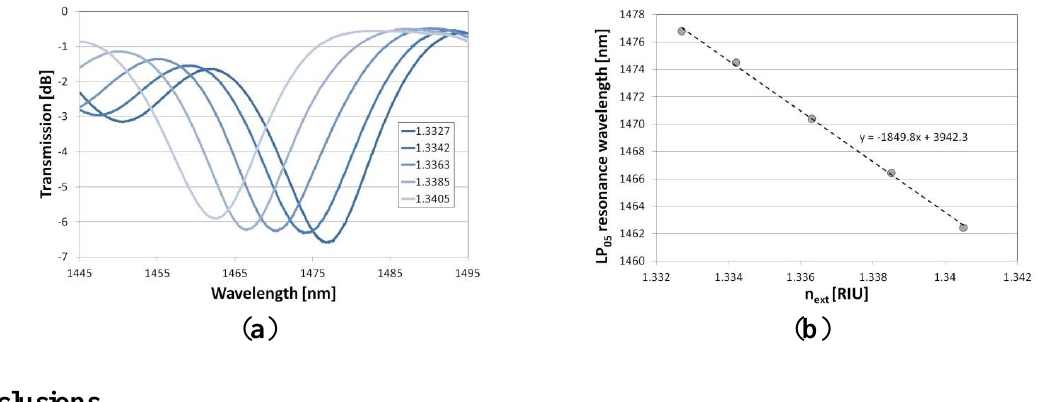
O overlay (205 nm in thickness) to 2 3 is given at λ = 589 ext